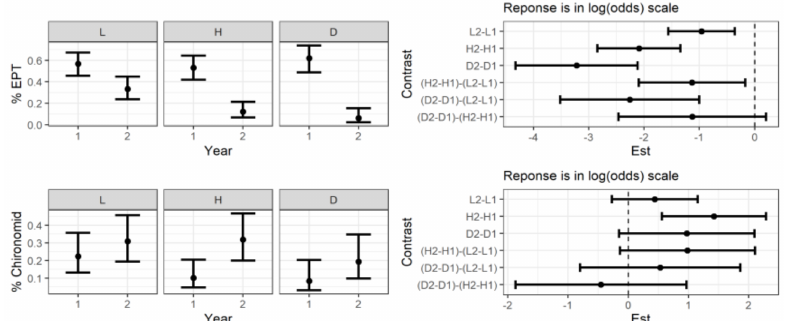
Figure 3. Estimated marginal means with 90% C.I.s of % EPT and % Chironomidae of total abundance before and after 2007 disturbance at low flood ( L ), high flood ( H ), and debris flow ( D ) disturbance categories (left) and contrasts between years (1–3, top) and relative differences in between categories (4–6, bottom)